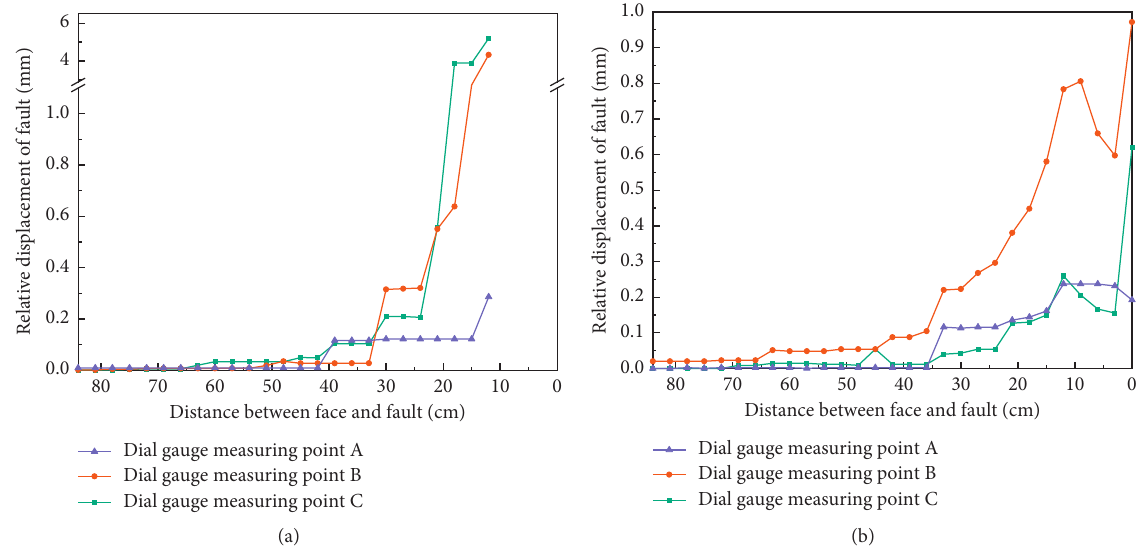
Figure 11: Relative displacements at the level of interruption of the extraction process. (a) Physical model I. (b) Physical model